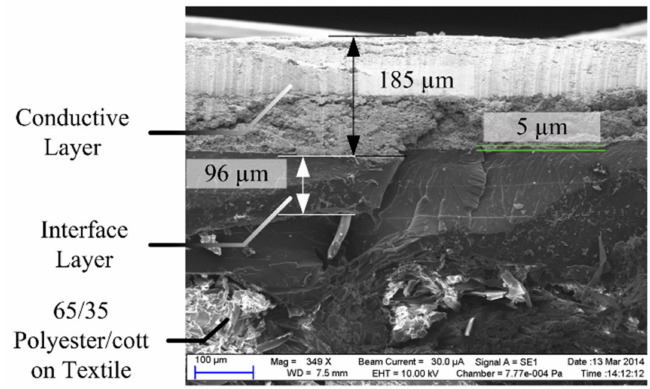
Figure 5. SEM image of the interface and conductive layer on textile. The interface layer provides a smooth surface for conductive layer over the